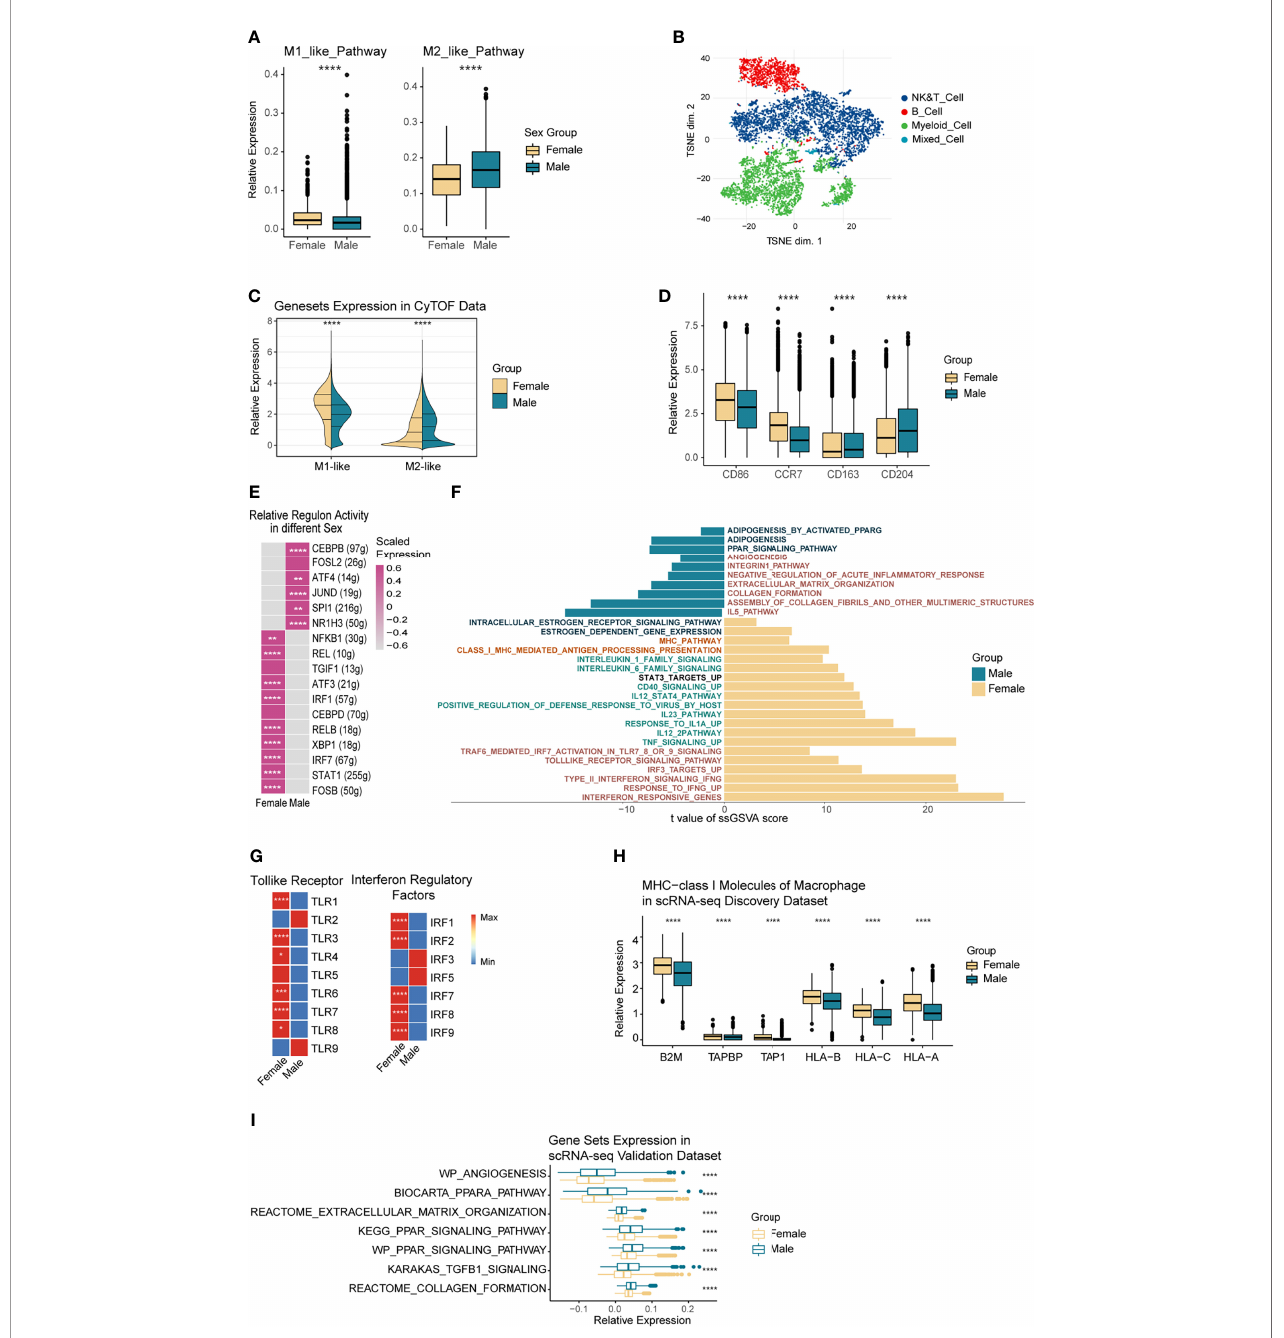
FIGURE 5 | Functional Heterogeneity of TAMs by Sex. (A) Boxplot comparing the M1 and M2 gene-sets expression of TAMs in the discovery scRNA-seq data, grouped by sex. (B) t-SNE plot showing the overall distribution of immune cells in 8 NSCLC patients, color-coded by corresponding cell type. (C) Split-violin plot showing the overall M1 and M2 associated proteins expressed by TAMs from female (left violins) and male (right violins) in the CyTOF data. (D) Boxplot showing the speci fi c M1 and M2 associated proteins expressed by TAMs in the CyTOF data, grouped by sex. (E) Heatmap showing the relative regulon activity of TAMs from different sexes in the discovery scRNA-seq data. (F) Differential pathways enriched in TAMs originated from different sexes. ssGSEA was used to calculate gene-set scores of every single cell, while the limma package executed differential analysis. (G) Heatmap showing the relative expression variance of Toll-like receptor and IRFs-associated genes in TAMs between sexes. (H) Boxplot showing the MHC I molecules of TAMs from different sexes in the discovery scRNA-seq data. (I) Boxplot showing the male up-regulated gene-sets of TAMs in the validation scRNA-seq data 1, colored by sex. *p < 0.05, **p < 0.01, ***p < 0.005, ****p <